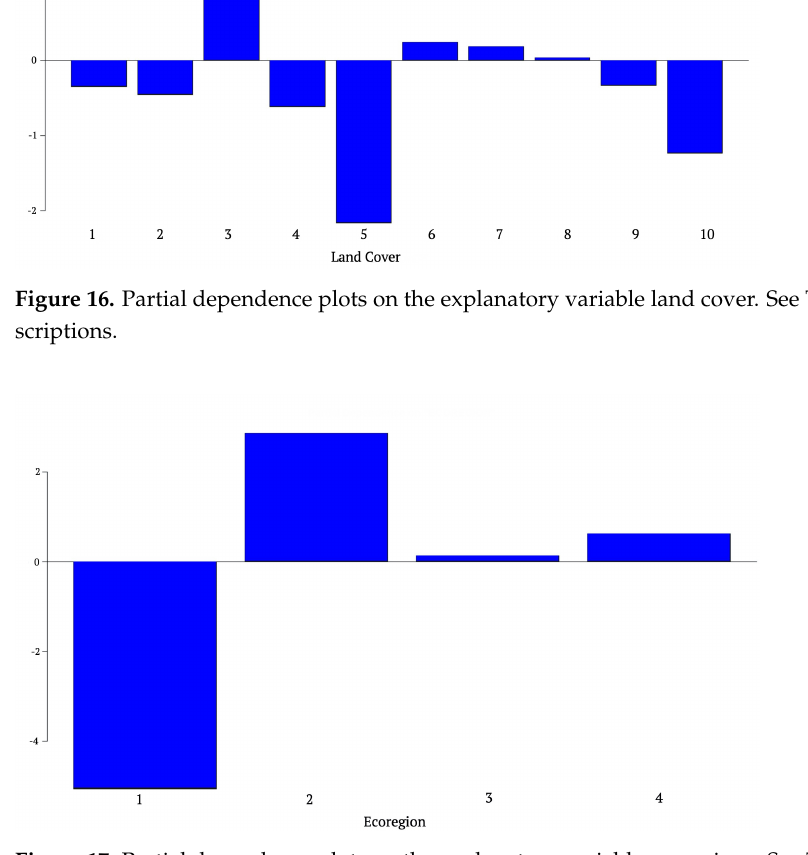
Figure 17. Partial dependence plots on the explanatory variable ecoregions. See Table 2 for class de-